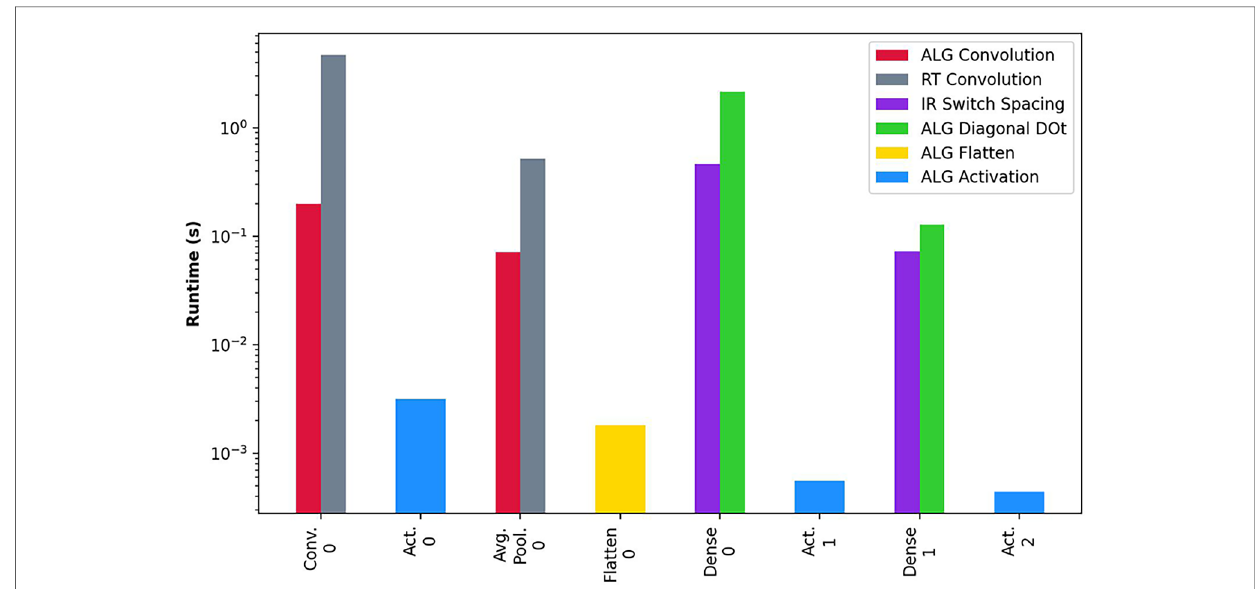
FIGURE 9 Performance evaluation Cryptonets Neural Network based on the CheXpert dataset. Average runtime of the execution of 250 random samples of the dataset. The ordering of the x -axis corresponds to the layer execution order (i.e., Conv. 0 is the fi rst layer, and Act. 2 is the last